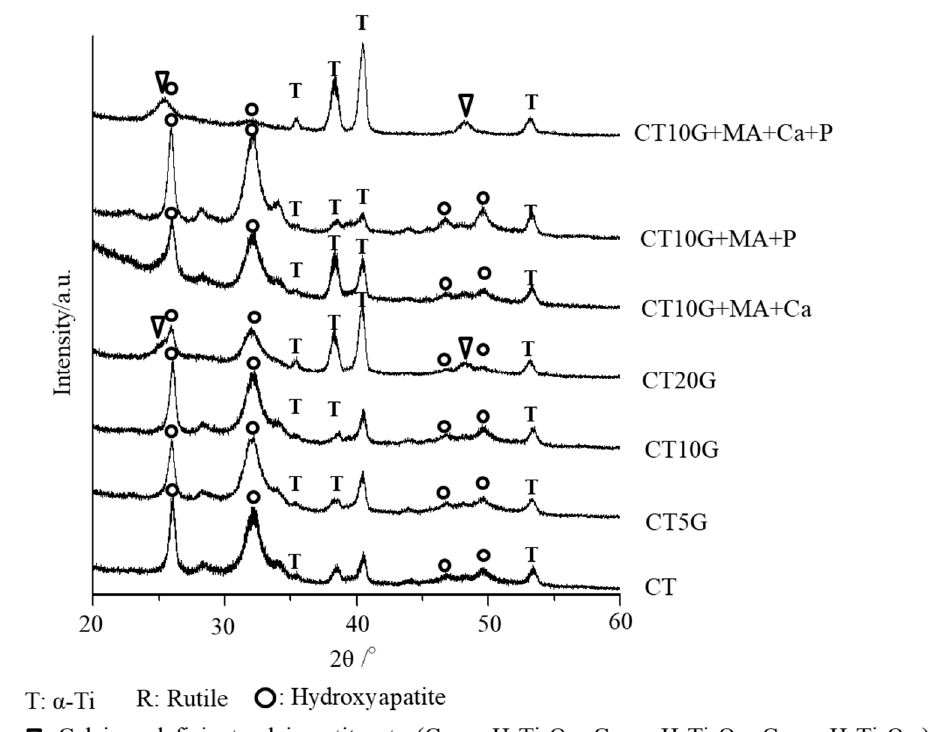
Figure 5. XRD profiles of surfaces of Ca–heat-treated Ti–6Al–4V alloy soaked in SBF for 7 days following dip coat treatment with various additives.